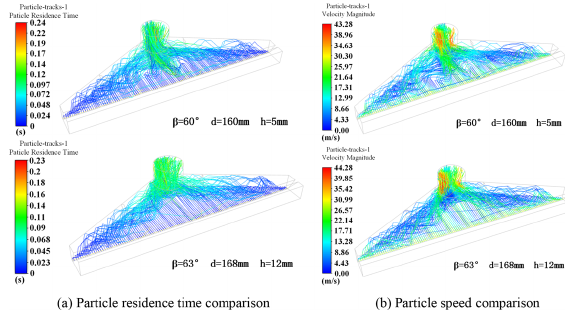
Figure 18. Comparison of particle trajectories before and after op-